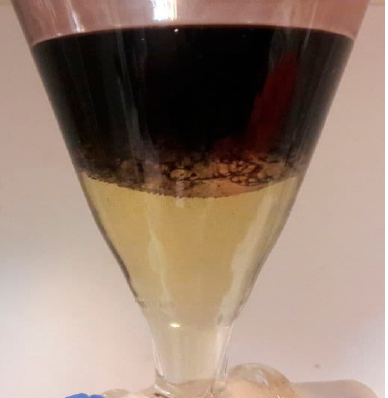
Figure 2. Separation of aqueous and organic phases (pH = 2.6, O/A = 1, Mextral 5640H = 10% ( v / v ), T = 25 °C).